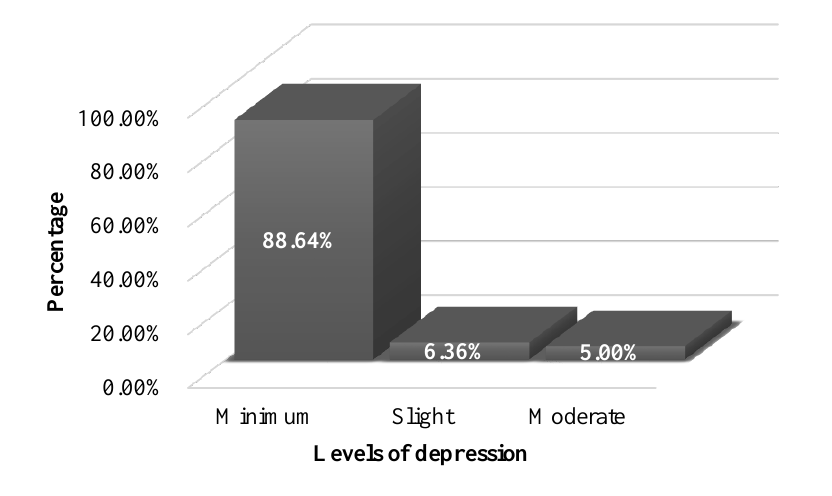
Figure 3. Level of depression of university students in Venezuela. Figure 4 shows the variable sense of life of Venezuelan students, where the highest percentage 55.45% is represented by students with a presence of meaning of life, followed by undefinition with 31.36% of students and 13.18% have a lack of meaning in life. These results are similar to those produced in students in Peru. However, it can be seen that Venezuelan students have a greater presence of life in times of the COVID-19 coronavirus pandemic. Moreover, according to Spearman's Rho test, there is a moderate negative relationship of -.579, indicating that there is inverse correlation in the depression level and life sense variables of college students at the time of the COVID-19 coronavirus